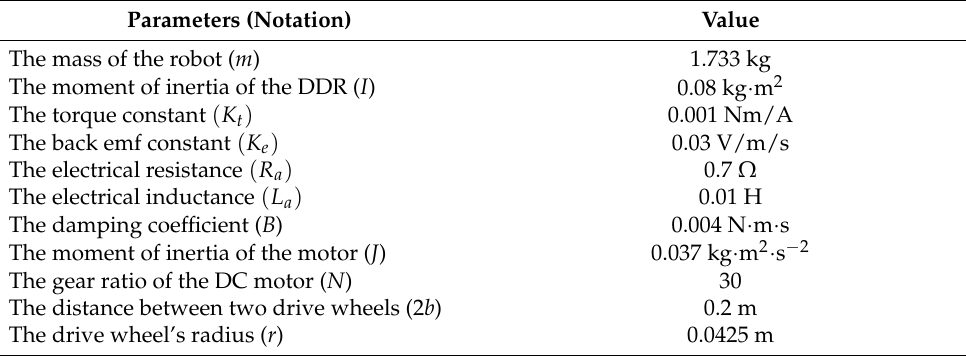
Table 6. The main parameters of the DDR used for simulation.